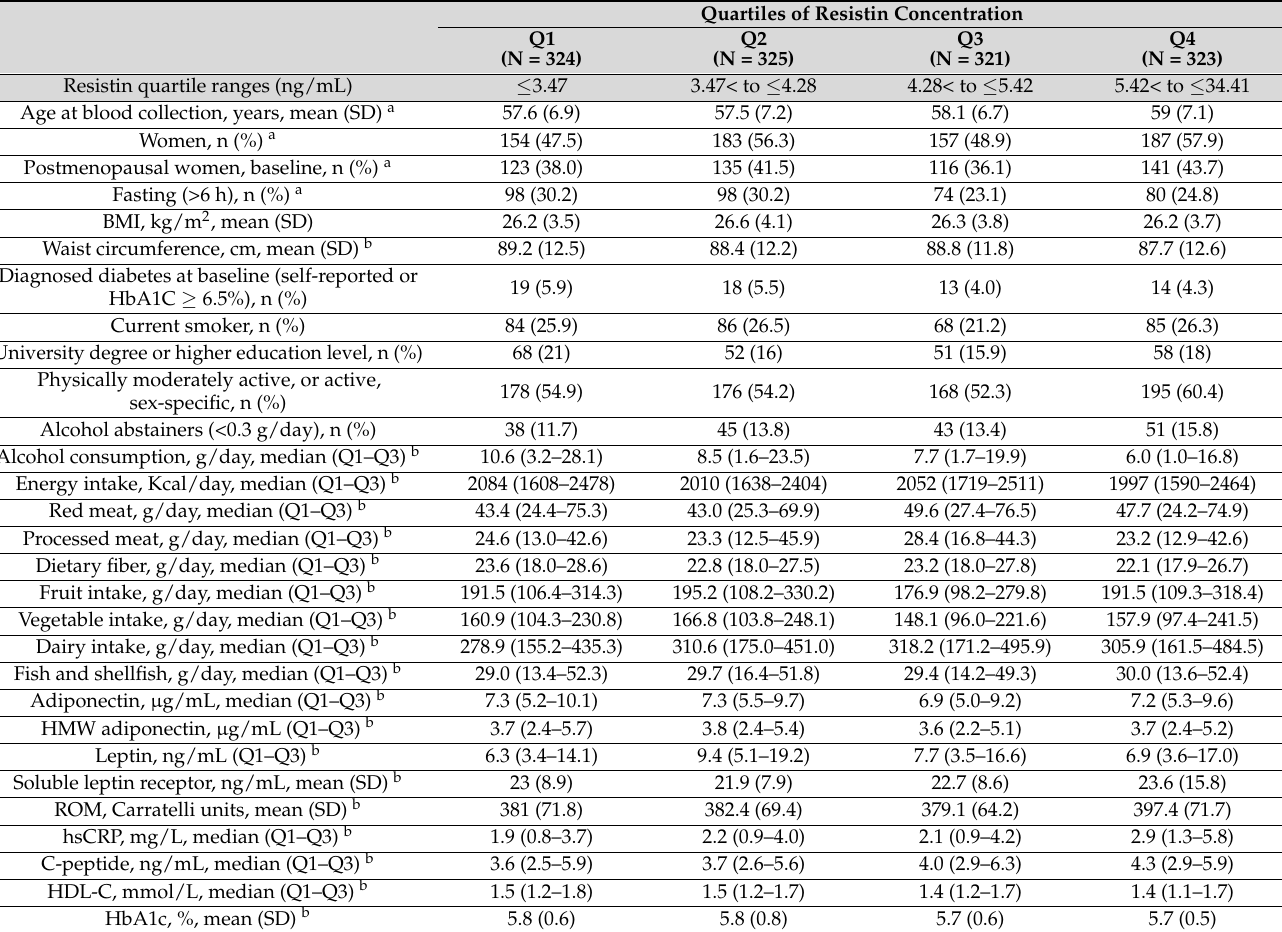
Table 1. Characteristics of controls at baseline (n = 1293), by quartiles of resistin concentration in the nested case-control study, European Prospective Investigation into Cancer and Nutrition,